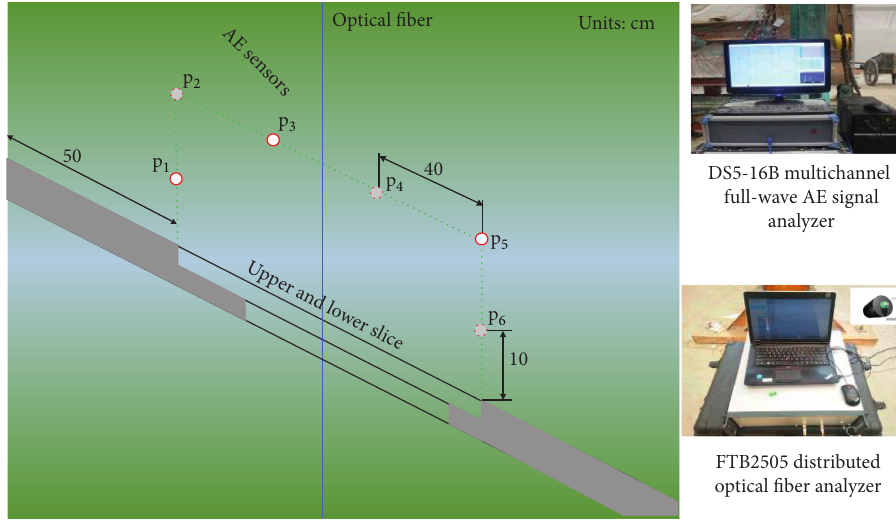
Figure 4: Monitoring